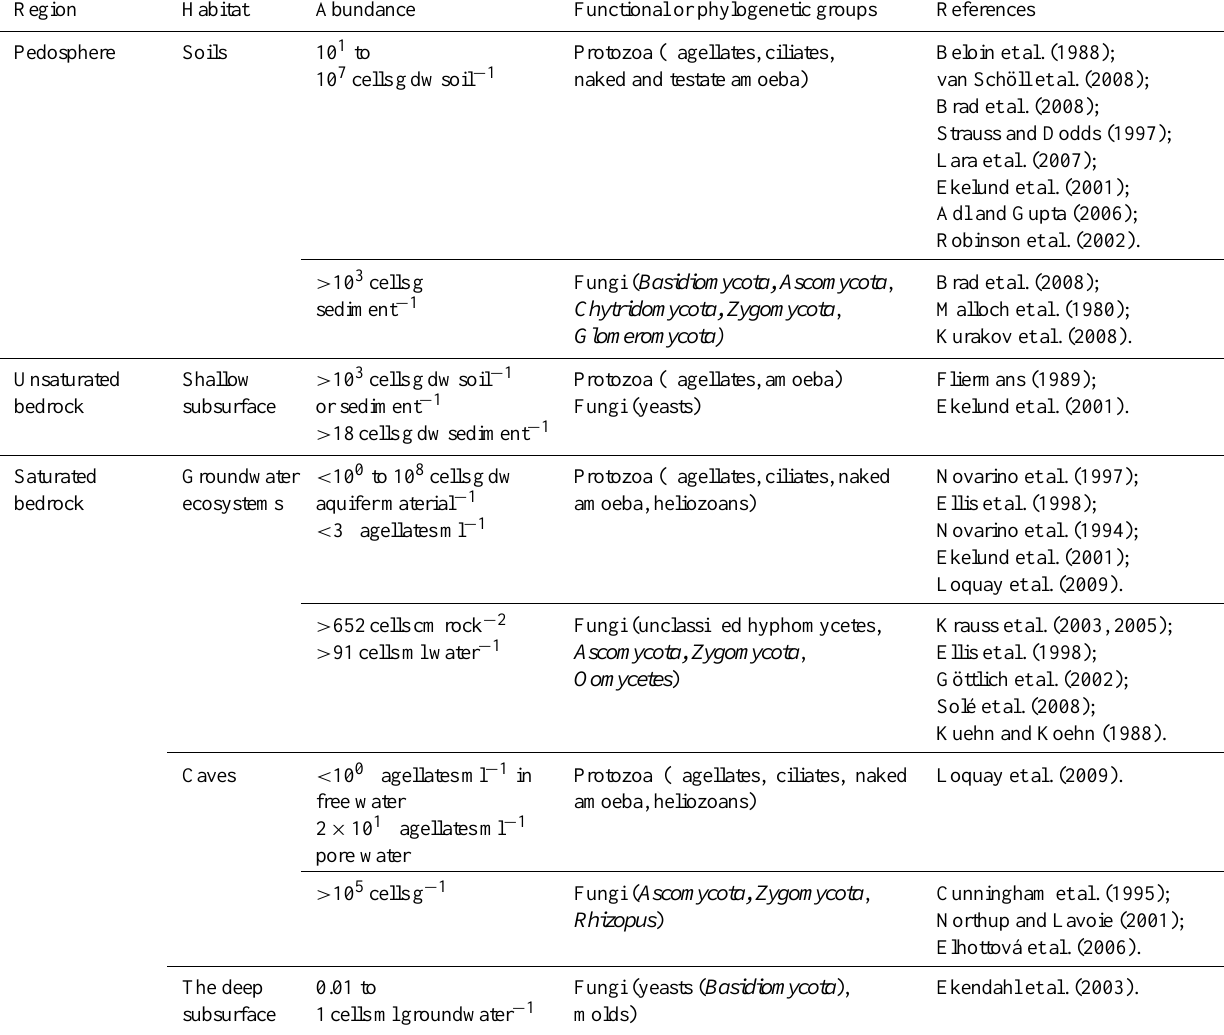
Table 2. Micro-eukaryote abundance and functional or phylogenetic diversity in CZ